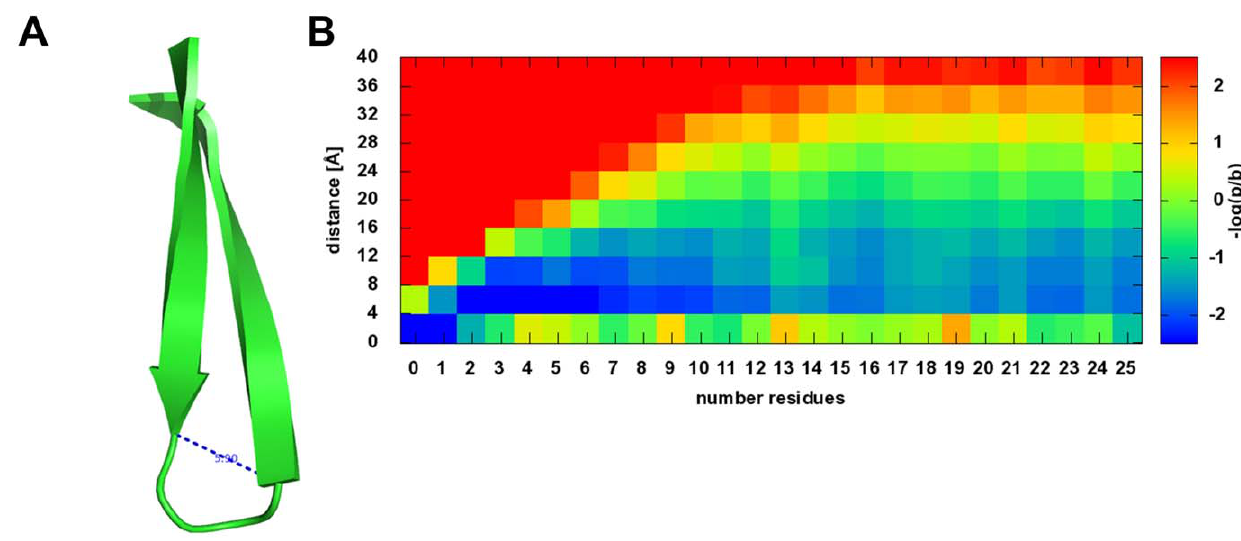
Figure 3. Loop closure potential. A describes two b -strands connected by a loop characterized by the Euclidean distance between the two ends and the number of residues in the loop connecting those two ends. B describes the derived energy potential, where the energy is a function of the number of residues in the loop and the Euclidean distance between the ends of the main axes.